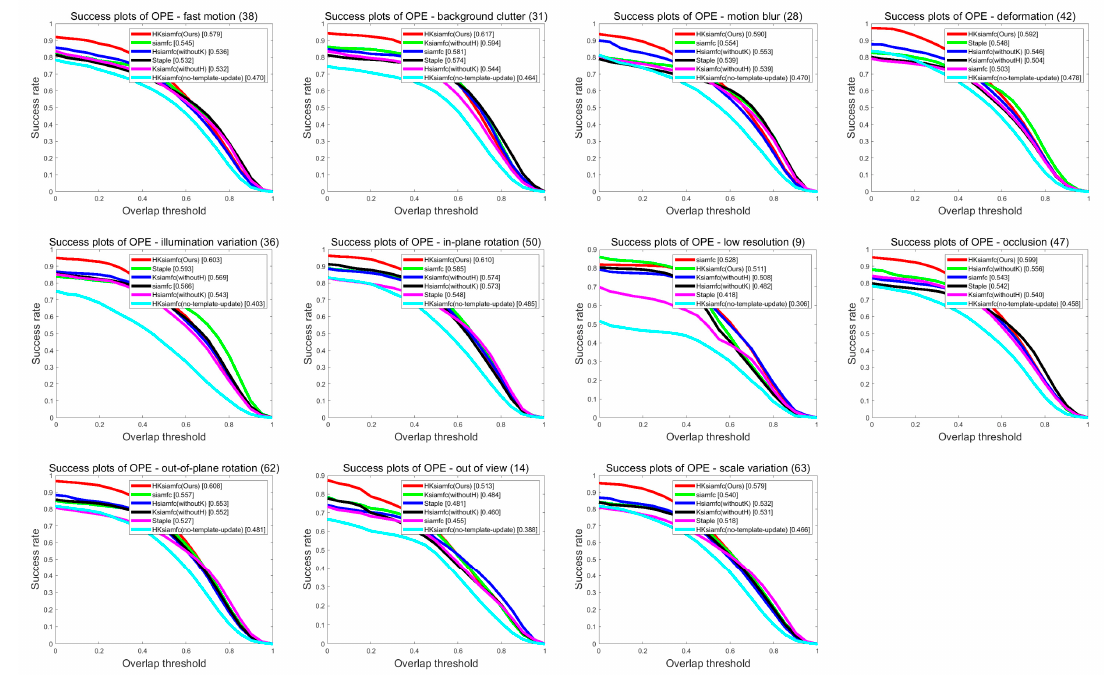
Figure 7. Comparison of HKSiamFC and five baseline trackers using success-plot metric under the 11 tracking scenarios. This picture is best viewed on high-resolution displays.